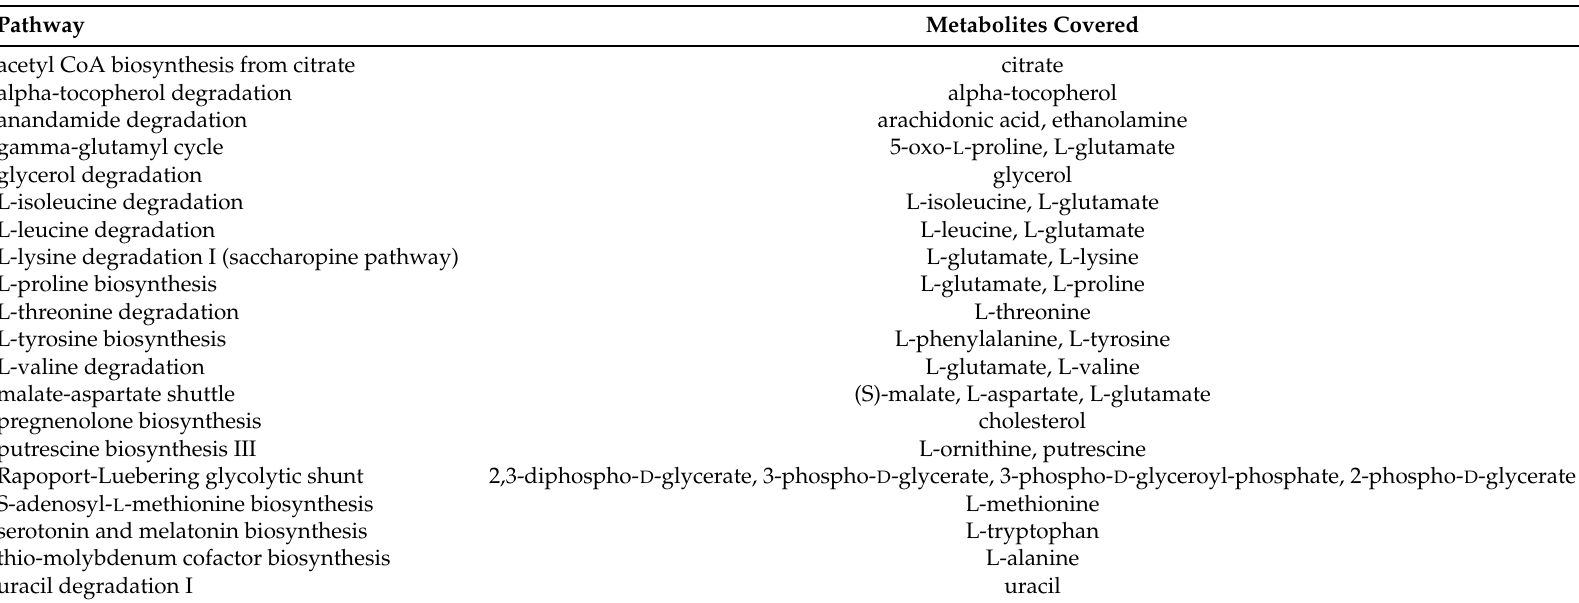
Table A3. ST000061, Pathway Covering Using Biosynthesis-Preferred Cost